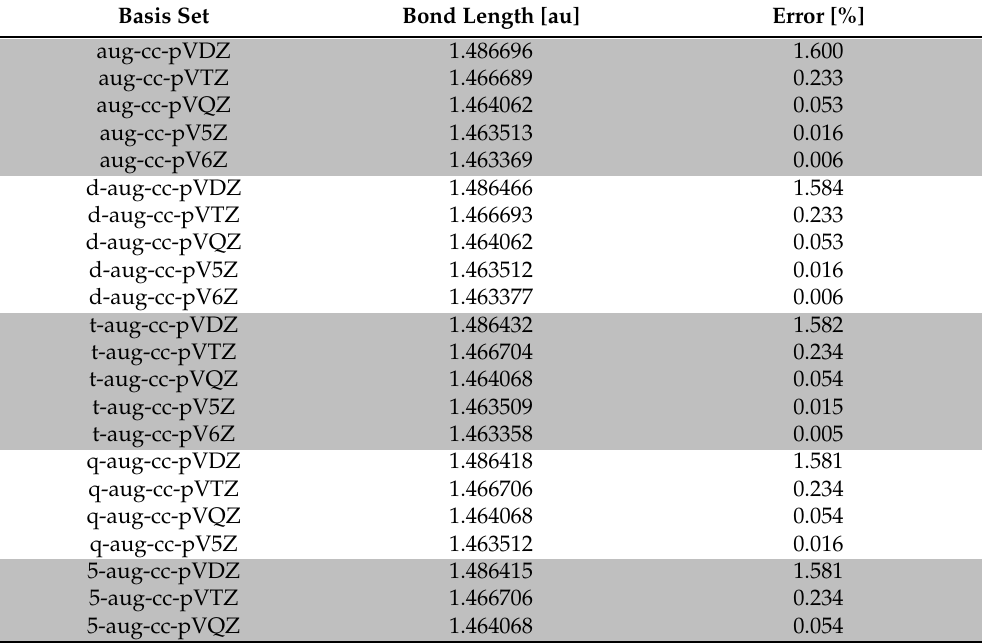
Table 1. The bond lengths of the isolated HeH + obtained using CCSD method and various basis sets and relative errors calculated with respect to the reference bond length value ( R = 1.463283 a.u.). Basis Set Bond Length [au] Error [%] aug-cc-pVDZ 1.486696 1.600